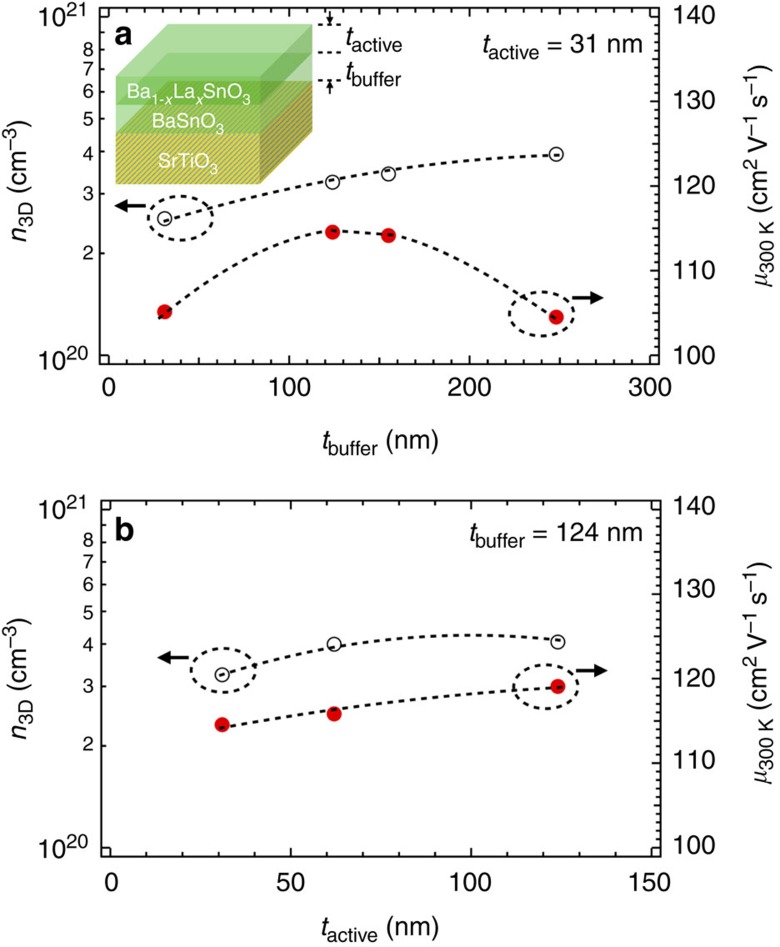
Effect of buffer and active layer thicknesses on room temperature carrier density and mobility.Variation of n3D (black open circles) and μ300 K (red solid circles) in doped BaSnO3 films as a function of (a) tbuffer for fixed tactive=31 nm, and (b) tactive for fixed tbuffer=124 nm. Inset shows a schematic of the structure.